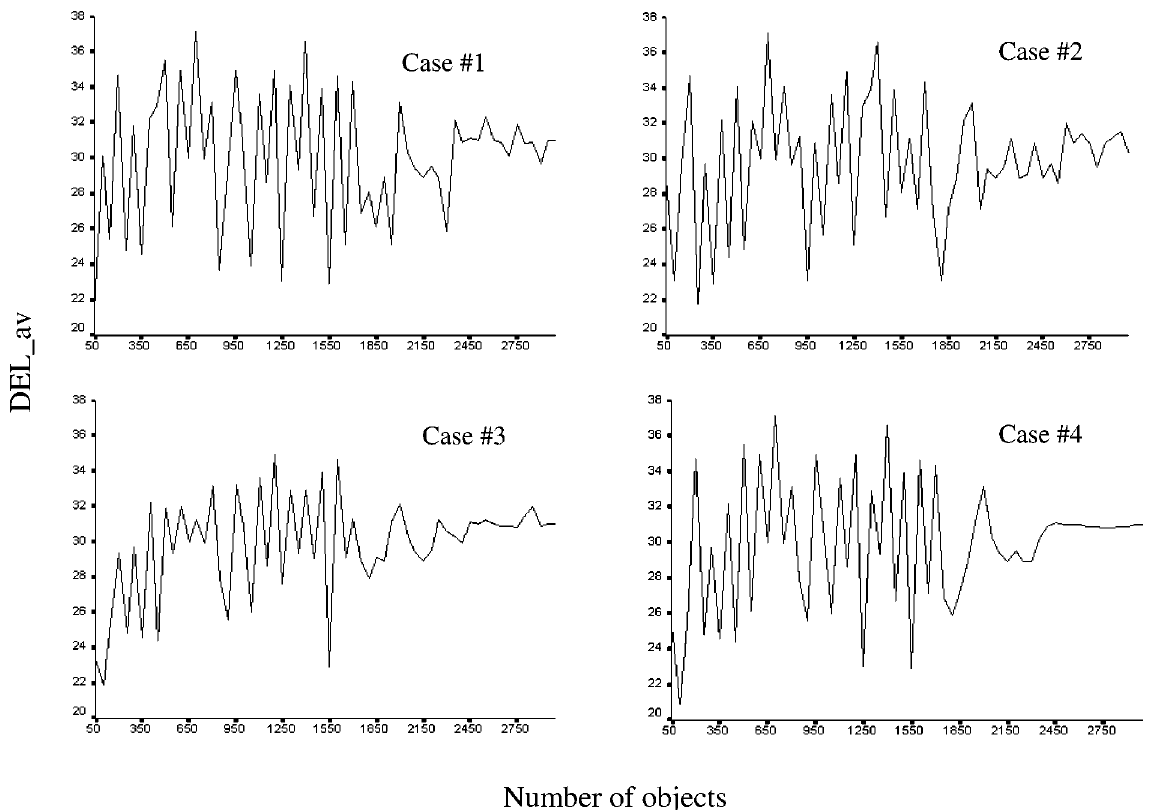
Fig. 3. Reproducibility as a function of number of cells analysed for one single structural feature in different cases of the cervical carcinomas. The number of cells required to achieve reproducible values for the structural feature DEL_av varies somewhat between cases. However, this variation was significantly less than the variation observed between different tissues ( P = 0 :